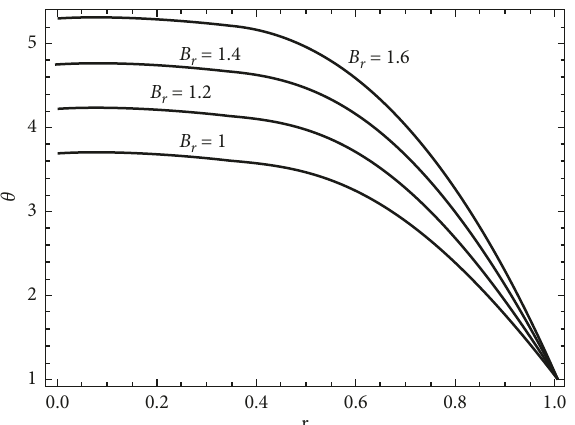
Figure 16: Variation of N r , where u with z for different values of K , where P 0 � 43, B r � 1, We 2 � 0.0001, n �− 1, and m �